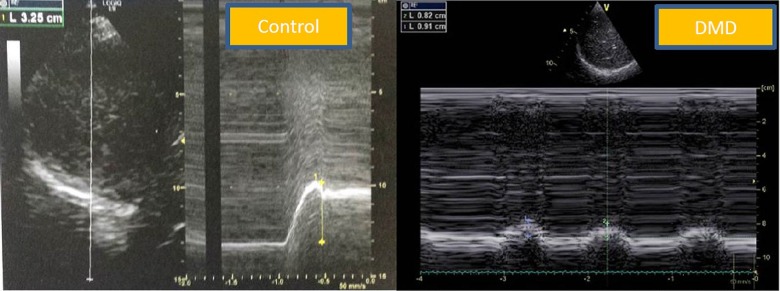
Diaphragm ultrasound displacement from the subcostal view in a control subject and in a DMD patient.Normal right diaphragm sniff time movement (TM) motion in the control group (left); note the sharp upstroke during a sniff maneuver. Pathological right diaphragm motion during a sniff maneuver in a DMD patient (right). Note the reduced diaphragm motion with the sniff maneuver. DMD: Duchenne muscular dystrophy.